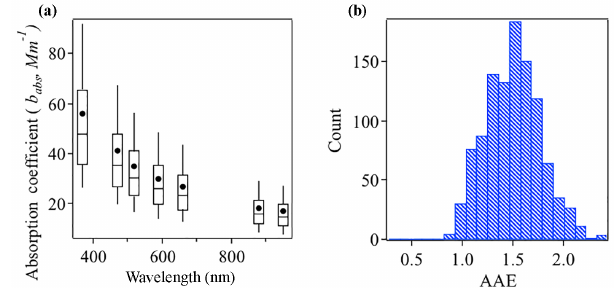
Figure 2. (a) Box-and-whisker plot of absorption coefficient at seven wavelengths as measured with the AE33. (b) Histogram of AAE values over the measurement campaign.